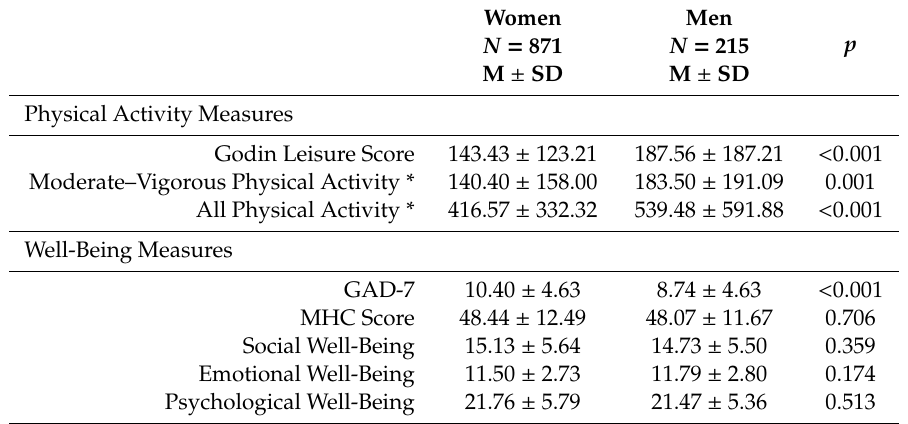
Table 2. t -Tests Results Comparing Women and Men on Physical Activity and Well-Being Measures.